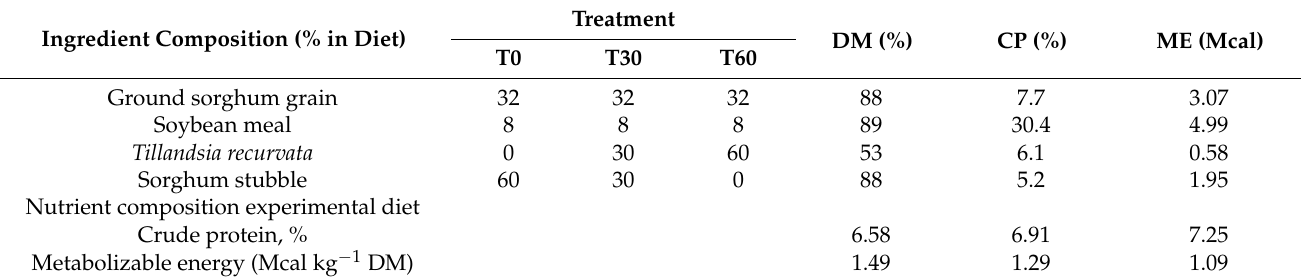
Table 1. Ingredients and chemical composition of experimental diets (DM basis) containing different levels of Tillandsia recurvata .